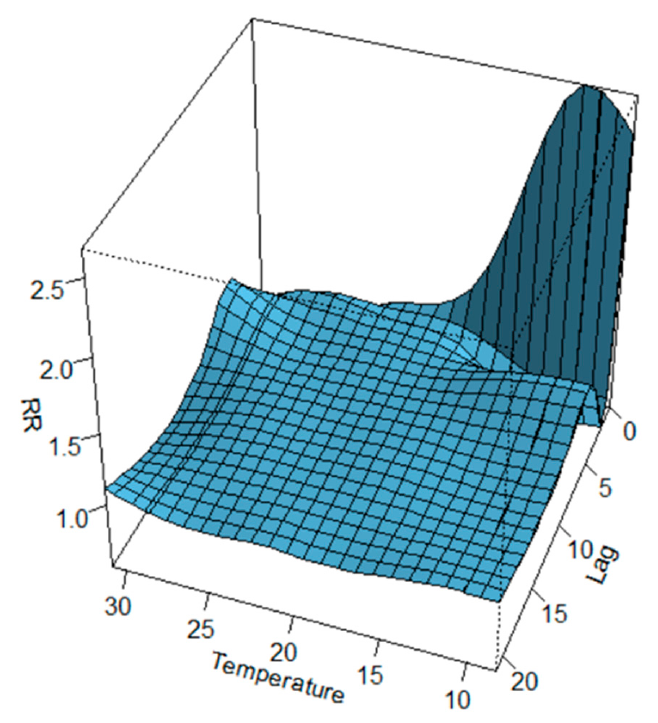
Figure 7. 3D plot of RR of CVD hospital admissions along temperature and lags with references of 20 °C.